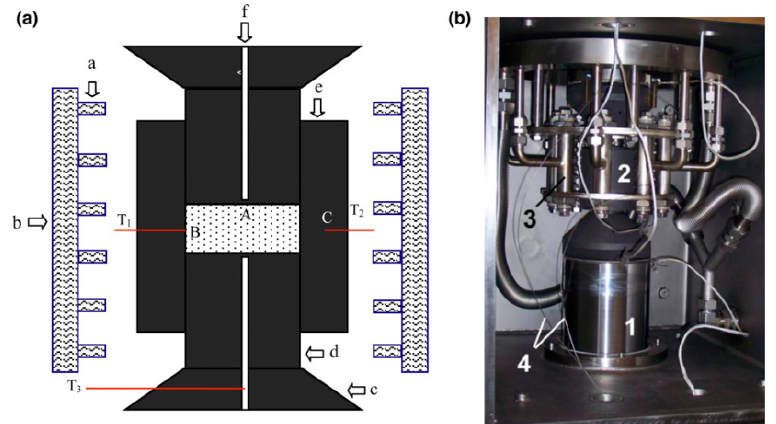
Figure 12. ( a ) Schematic illustrating modifications in the SPS chamber with the gas quenching system. Herein, a: gas nozzles, b: gas tube. C: graphite cone, d: graphite punch, e: graphite foam, f: pyrometer hole for temperature measurement at position A; T 1 , T 2 , and T 3 are the thermocouples to measure sample temperatures, respectively, at position B, graphite foam C, and graphite cone. ( b ) Photograph of the SPS chamber. Reproduced with permission from reference [87].